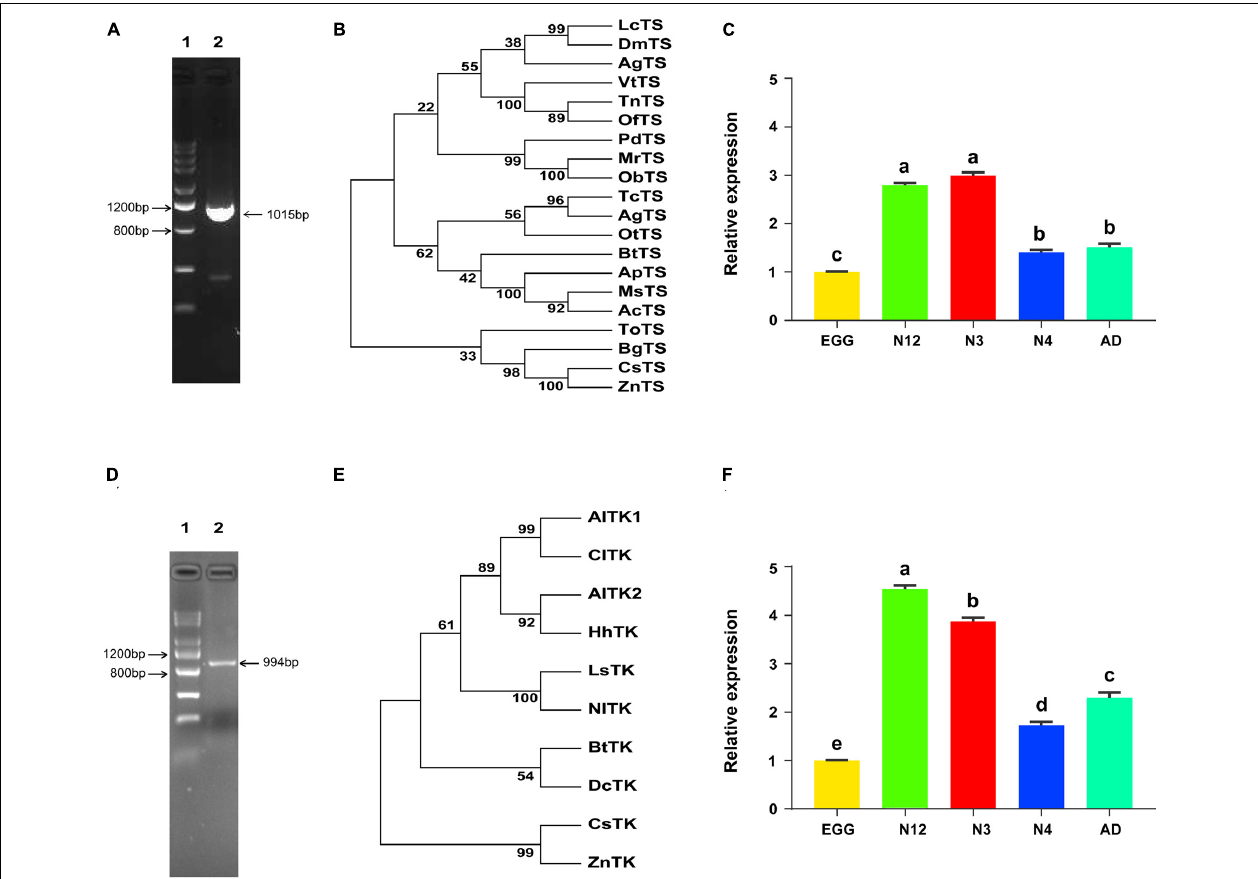
FIGURE 3 | Cloning, phylogenetic analysis and expression patterns of both BtTS and BtTK. (A,D) Complete coding sequence amplification of BtTS and BtTK from MED. For panel (A) , line 1, Tiangen DNA marker III; line 2, BtTS. For panel (D) , line 1, Tiangen DNA marker III; line 2, BtTK. (B,E) Phylogenetic tree of BtTS and BtTK from MED. LcTS, Lucilia cuprina , XP_023302452.1; DmTS, Drosophila melanogaster , NP_001285570.1; AgTS, Anopheles gambiae , XP_311491.3; VtTS, Vanessa tameamea , XP_026491376.1; TnTS, Trichoplusia ni , XP_026747379.1; OfTS, Ostrinia furnacalis , XP_028163869.1; PdTS, Polistes dominula ,